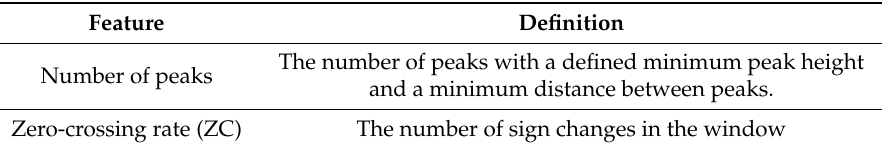
Table 2. Time-domain